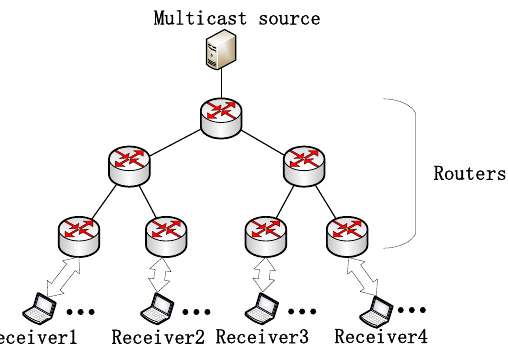
Figure 2. A three-layer multicast tree model.